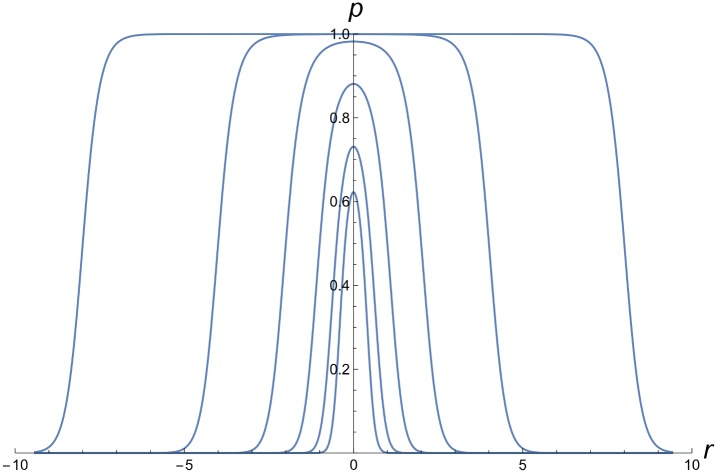
The statistical Model (7) describing the position and width of the wave.Assuming wave width w = 1, the figure illustrates the transition from a near-Gaussian distribution of infection frequencies near the centre of the release (for r0 = 0.25, 0.5) to a wave traveling in both directions (for r0 = 1, 2, 4, 8).